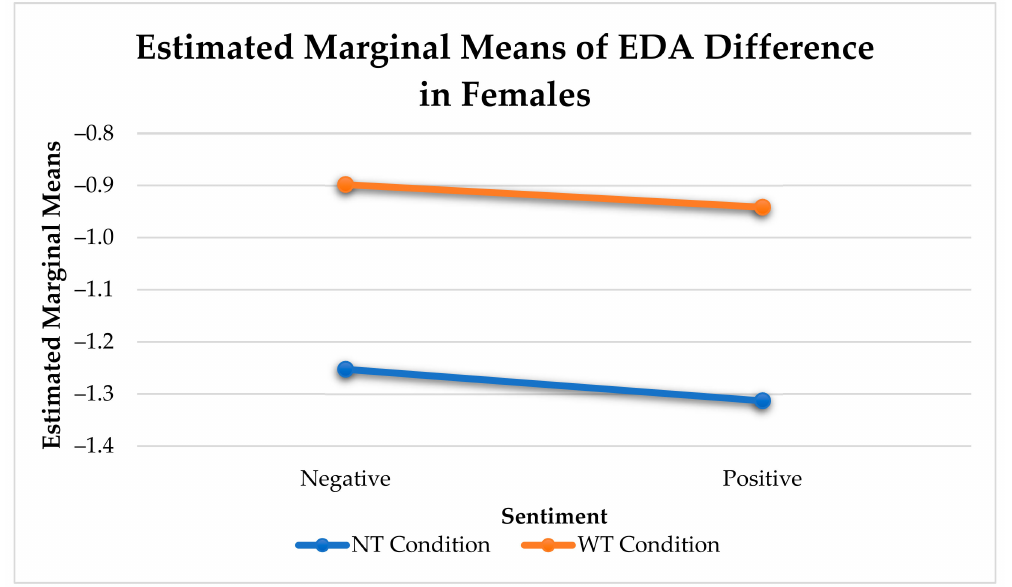
Figure 6. Change in Physiological Arousal Elicited by Sentiment and Touch for Females.